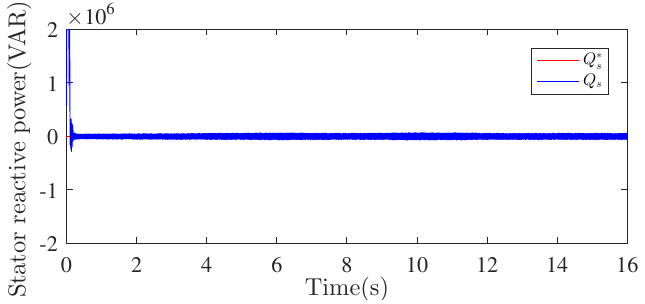
Figure 12. Stator reactive power